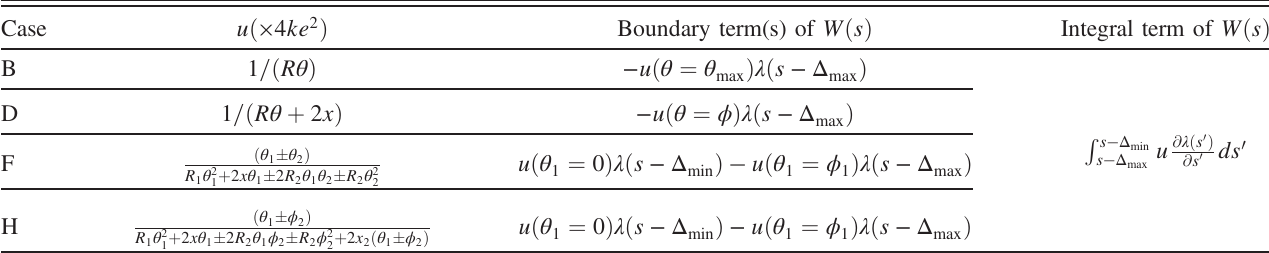
TABLE III. The function u and the wake expression W ð s Þ for even cases. Note that for case B and D there is one boundary term, and for case F and H there are two boundary terms (the near one at θ 1 ¼ 0 and the far one at θ 1 ¼ ϕ 1 ). Case u ð × 4 ke 2